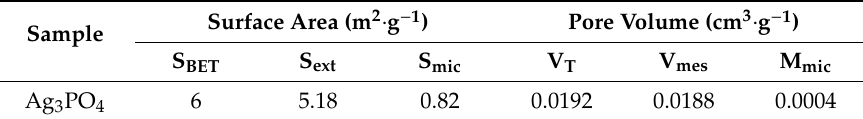
Figure 4. FTIR spectrum of Ag 3 PO 4 .